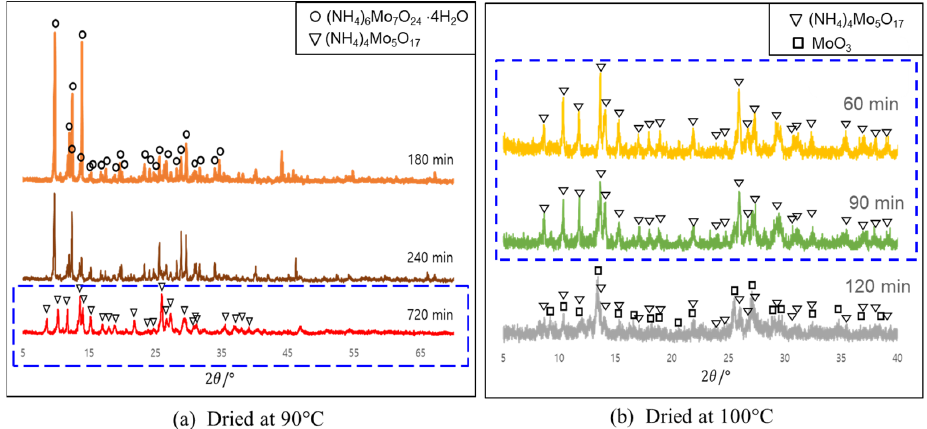
Figure 3. XRD analyses of APT with drying time at 90 °C and 100 °C .